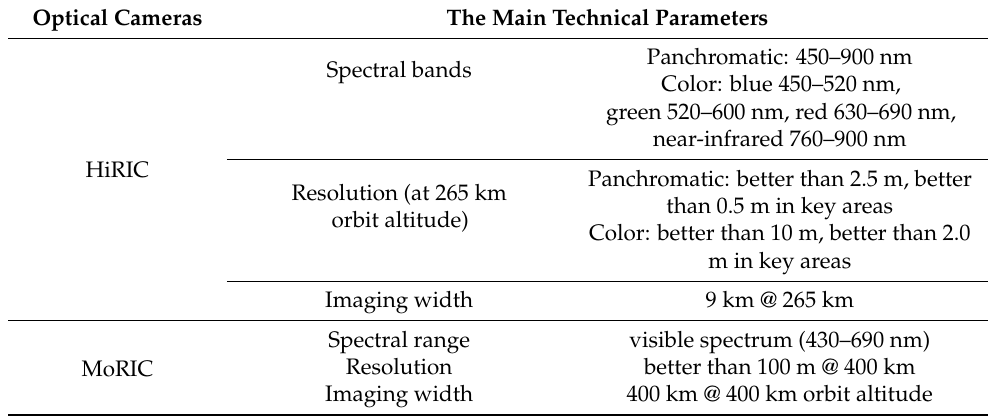
Figure 4. The retrieved optical depth at different solar longitude (the blue error bars represents the optical depth in the candidate landing area calculated by the shadow method, red error bars represent the optical depth divided by the correction coefficient, and green dots represents the number of dust storm activity recorded in the Mars Dust Activity Database (MDAD) at 10°–40°N [28]). Table 2. The main technical parameters of the optical cameras onboard the orbiter of Tianwen-1.